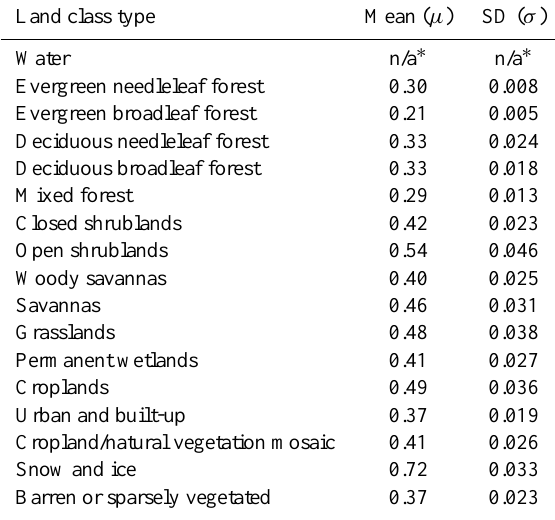
Table A1. Mean ( µ ) and standard deviation ( σ ) of snow-covered surface albedo for different land class types. The averaging filter used to determine snow presence was based on both MODIS and NISE data sets of snow, and thus these averages are specific to the current study. MODIS provides surface albedo only over land, so albedo for water cannot be